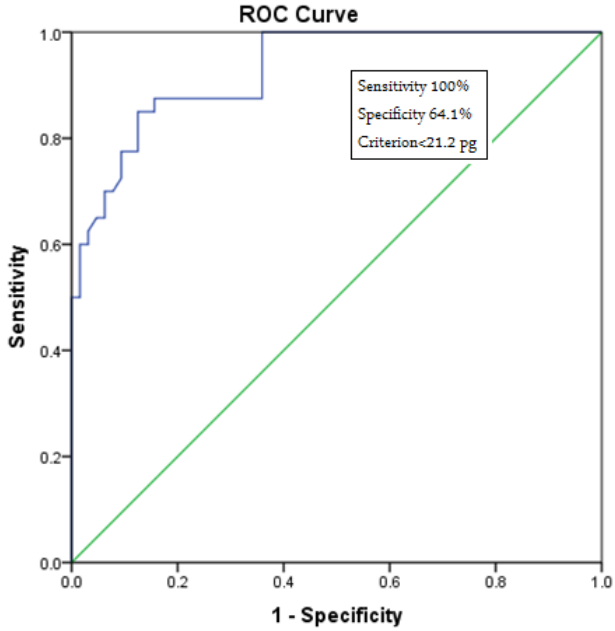
Figure 1. Receiver operating characteristic (ROC) curve analysis for reticulocyte hemoglobin levels in normal individuals and patients with IDA. This figure indicates the cutoff value for Ret-Hb, the lower value of which suggests IDA (cuto ff = 21.2 pg) with 100% sensitivity.